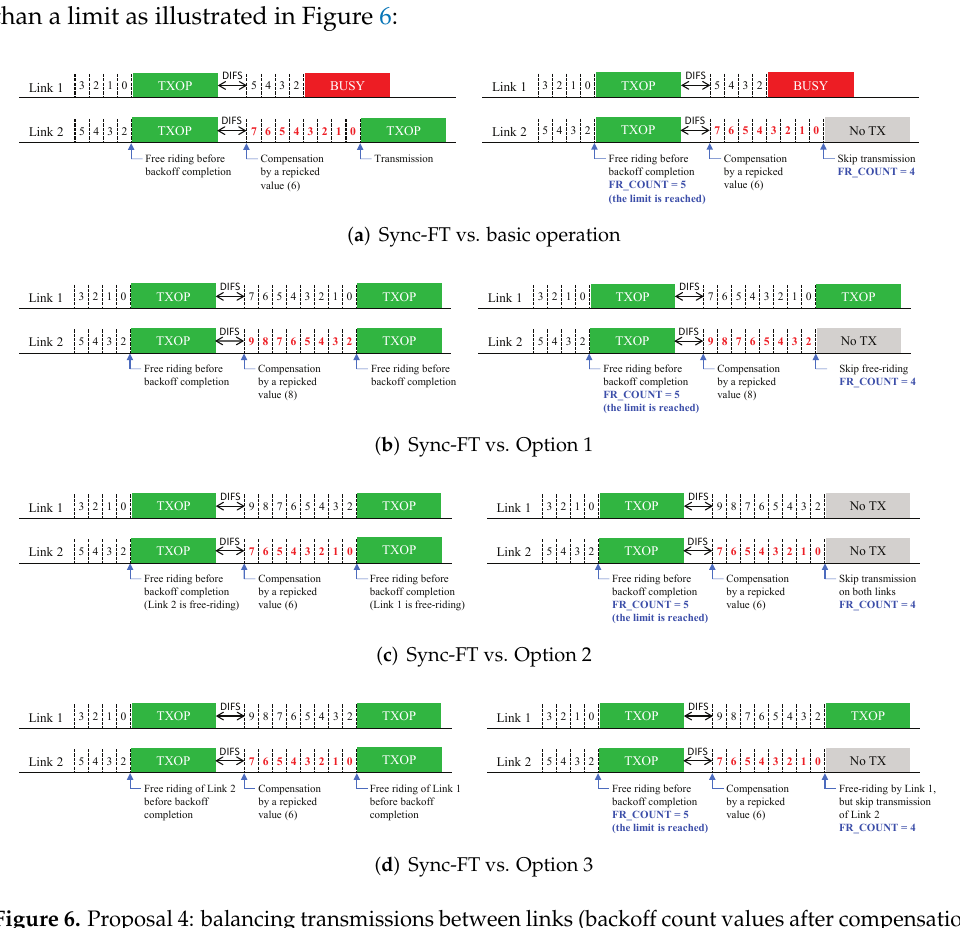
Figure 6. Proposal 4: balancing transmissions between links (backoff count values after compensation are colored